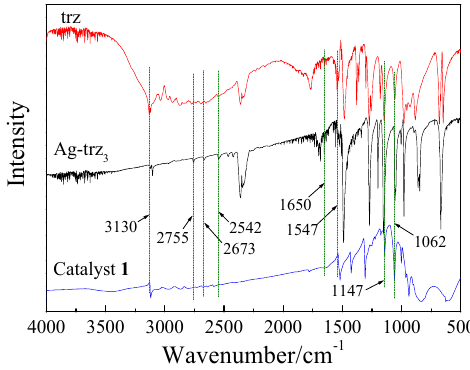
Figure 4. FT-IR spectra of fresh reference sample Ag-trz 3 , fresh 1,2,4-triazole and fresh catalyst 1 .